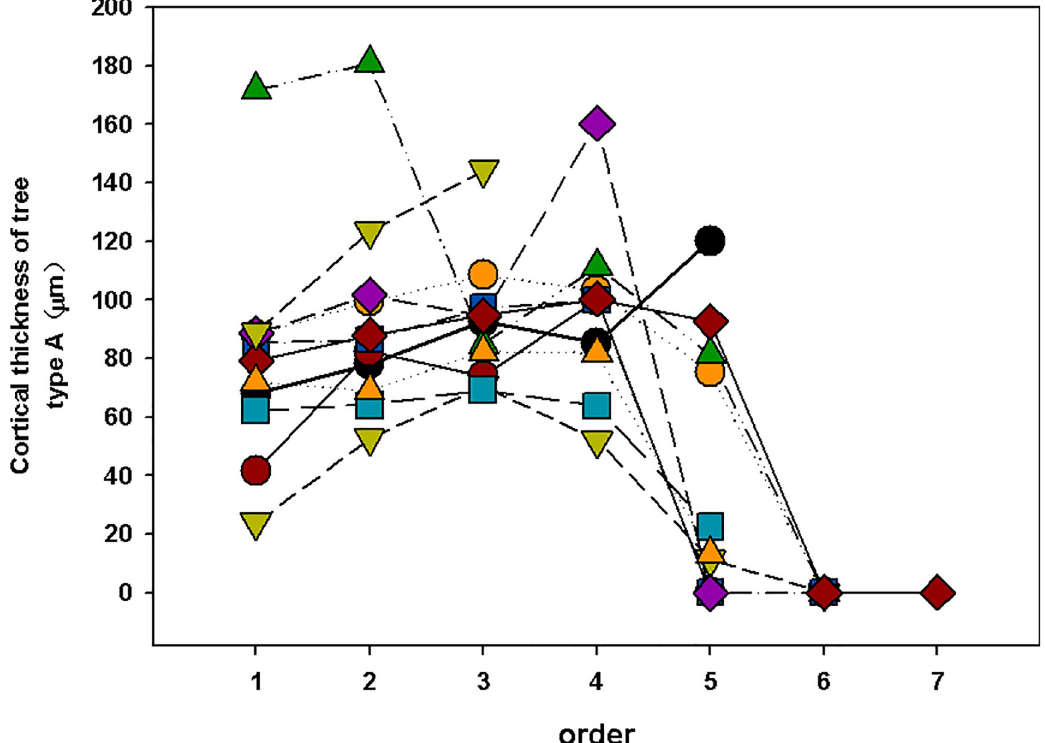
Fig 6. Cortical thickness of tree (type A). Type A: The cortex thickness increases in the first 3–4 order and then decline.